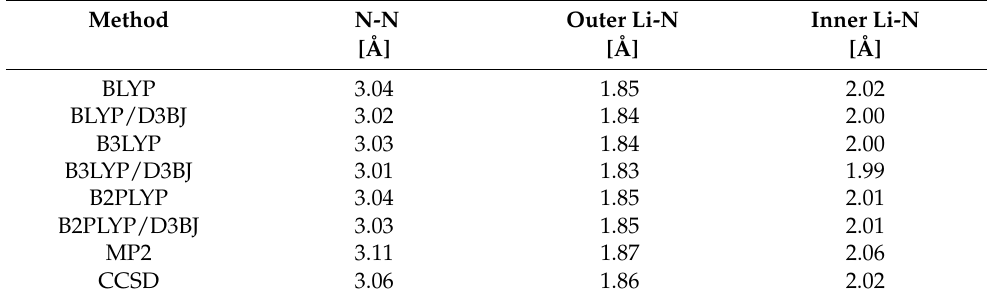
Table 2. Optimized Li 9 N 2 structure, method comparison. Each nitrogen atom is coordinated by six lithium atoms. The inner three lithium atoms are bound to both nitrogen atoms, see Figure 3.